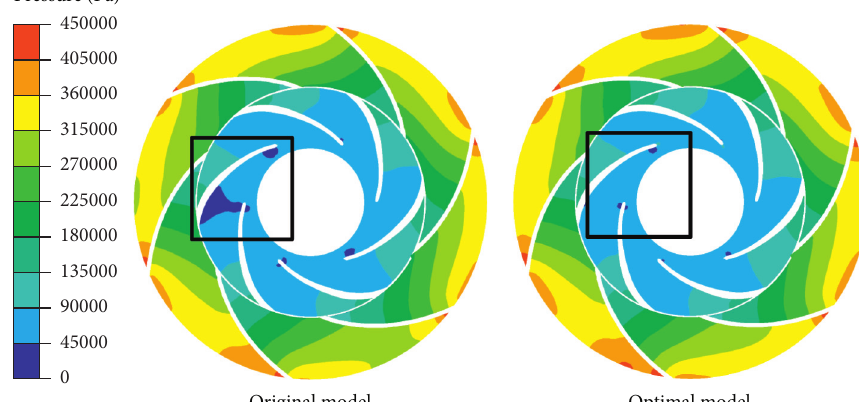
Figure 18: Comparison of pressure distribution at 1.2 Q